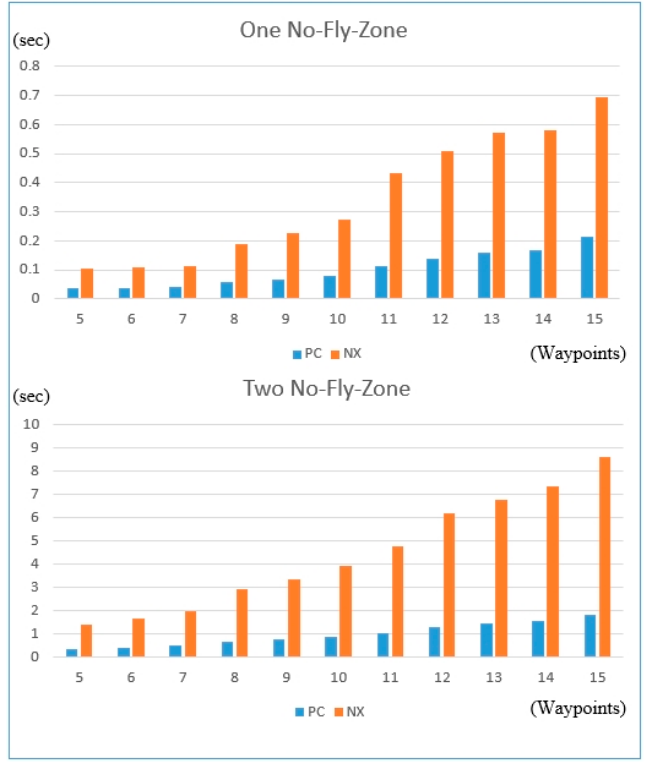
Figure 14. Calculation time of Cython on PC and Jetson Xavier NX.